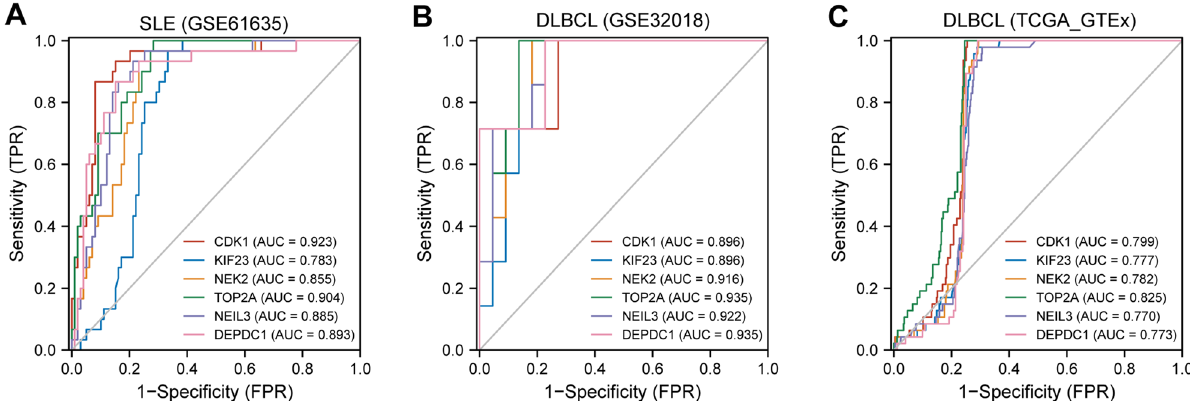
Figure 9. Verification of common diagnostic biomarkers. ( A ) The ROC curve used to verify the diagnostic efficacy in GSE61635. ( B ) The ROC curve used to verify the diagnostic efficacy in GSE32018. ( C ) The ROC curve used to verify the diagnostic efficacy in TCGA_GTEx